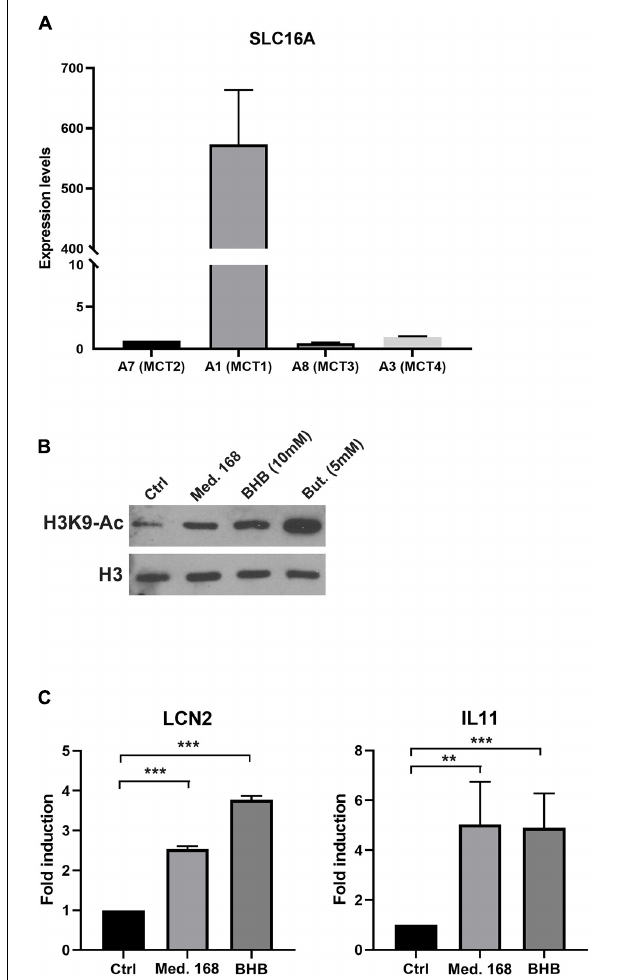
FIGURE 6 | Extracellular β -hydroxybutyrate leads to increased H3K9 histone acetylation and altered gene expression in 4T07 cells. (A) Expression levels of the slc16A family transporter genes in 4T07 were analyzed by RT-QPCR. Expression of HPRT served as normalization of the data. (B) H3K9 histone acetylation was analyzed by immunoblotting of extracts of 4T07 cells grown for 24 h in control, 168-conditioned medium or medium complemented with β -hydroxybutyrate or with butyrate, as indicated. Total histone 3 (H3) abundance served as normalization control. (C) 4T07 cells cultured for 3 days were incubated for 8 h with 4T07- (Ctrl) or 168-conditioned medium or purified β -hydroxybutyrate (10 mM) added to fresh medium. Total RNAs were purified and subjected to RT-QPCR with specific primers for LCN2 and IL-11. ** p < 0.01, *** p < 0.001.